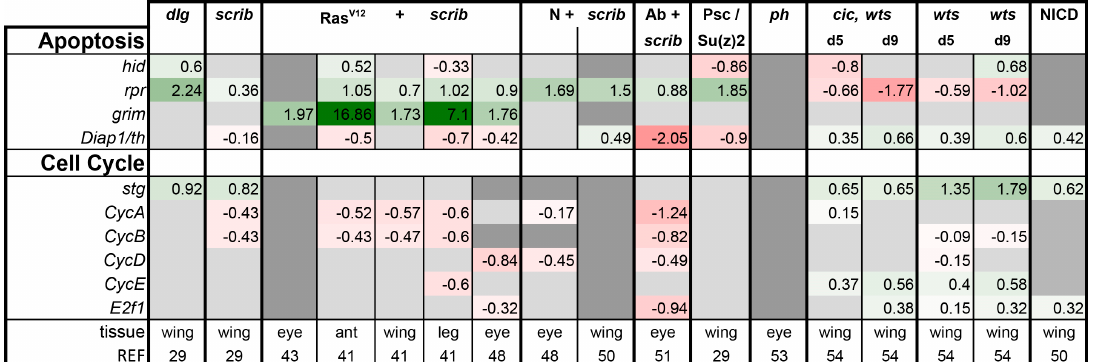
autonomous versus non-autonomous gene induction and is limited by the single time point.